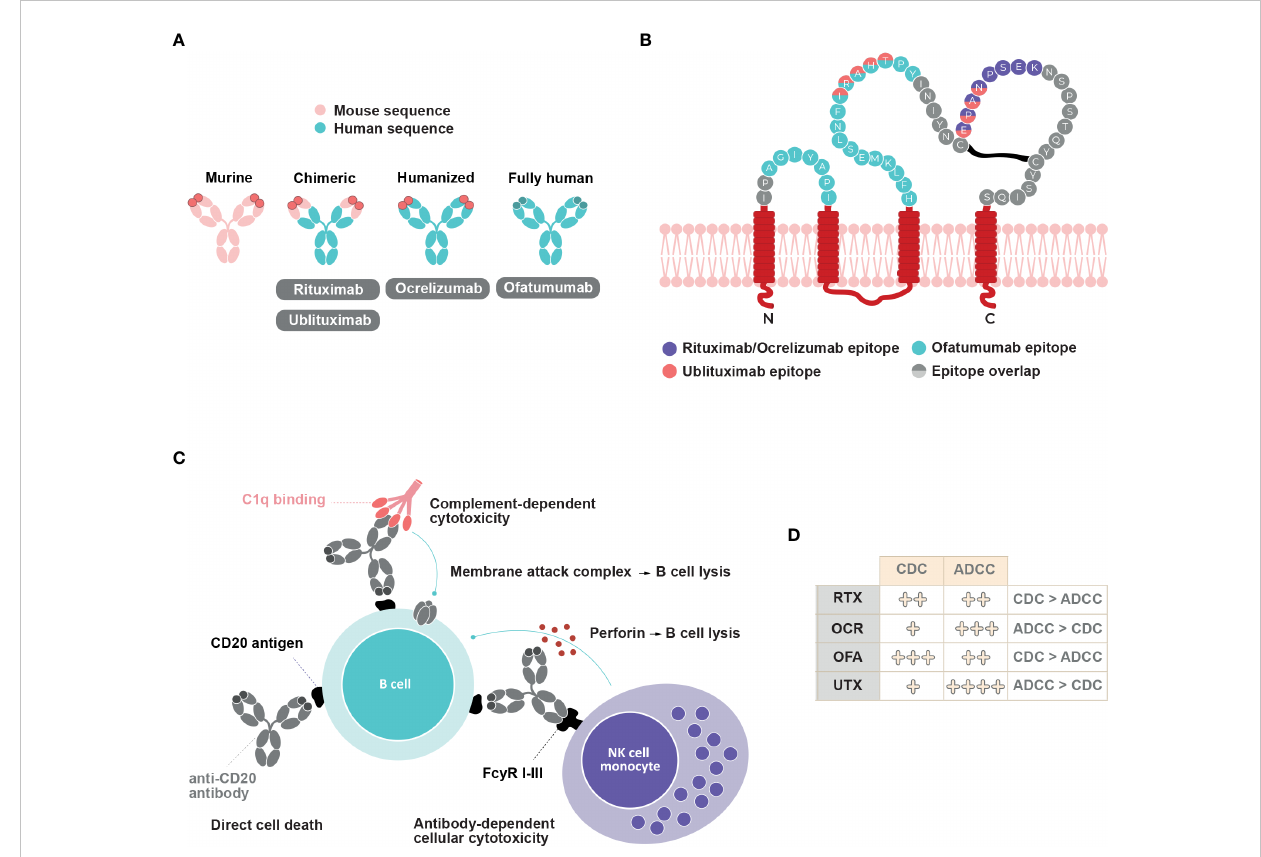
FIGURE 2 Anti-CD20 mAbs structure, epitope binding and mechanisms of action. (A) Structure of rituximab, ocrelizumab, ofatumumab and ublituximab antibodies (B) Binding epitopes of rituximab, ocrelizumab, ofatumumab and ublituximab on CD20. Adapted from Fox, 2021 (46) (C) Schematic representation of different mechanisms of action involved upon anti-CD20 mAbs binding and their relative contribution (D) . CDC, complement dependent cytotoxicity; ADCC, antibody-dependent cellular cytotoxicity; RTX, rituximab; OCR, ocrelizumab; OFA, ofatumumab; UTX,